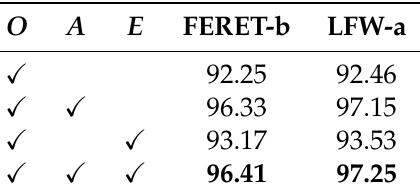
Table 3. Rank-1 identification rates (%) of the proposed method when fusing the match scores of the original images (denoted by O ) and the match scores of the enriched invariant features (denoted by A ) or the match scores of the enriched images (denoted by E ) on the FERET-b and LFW-a databases.